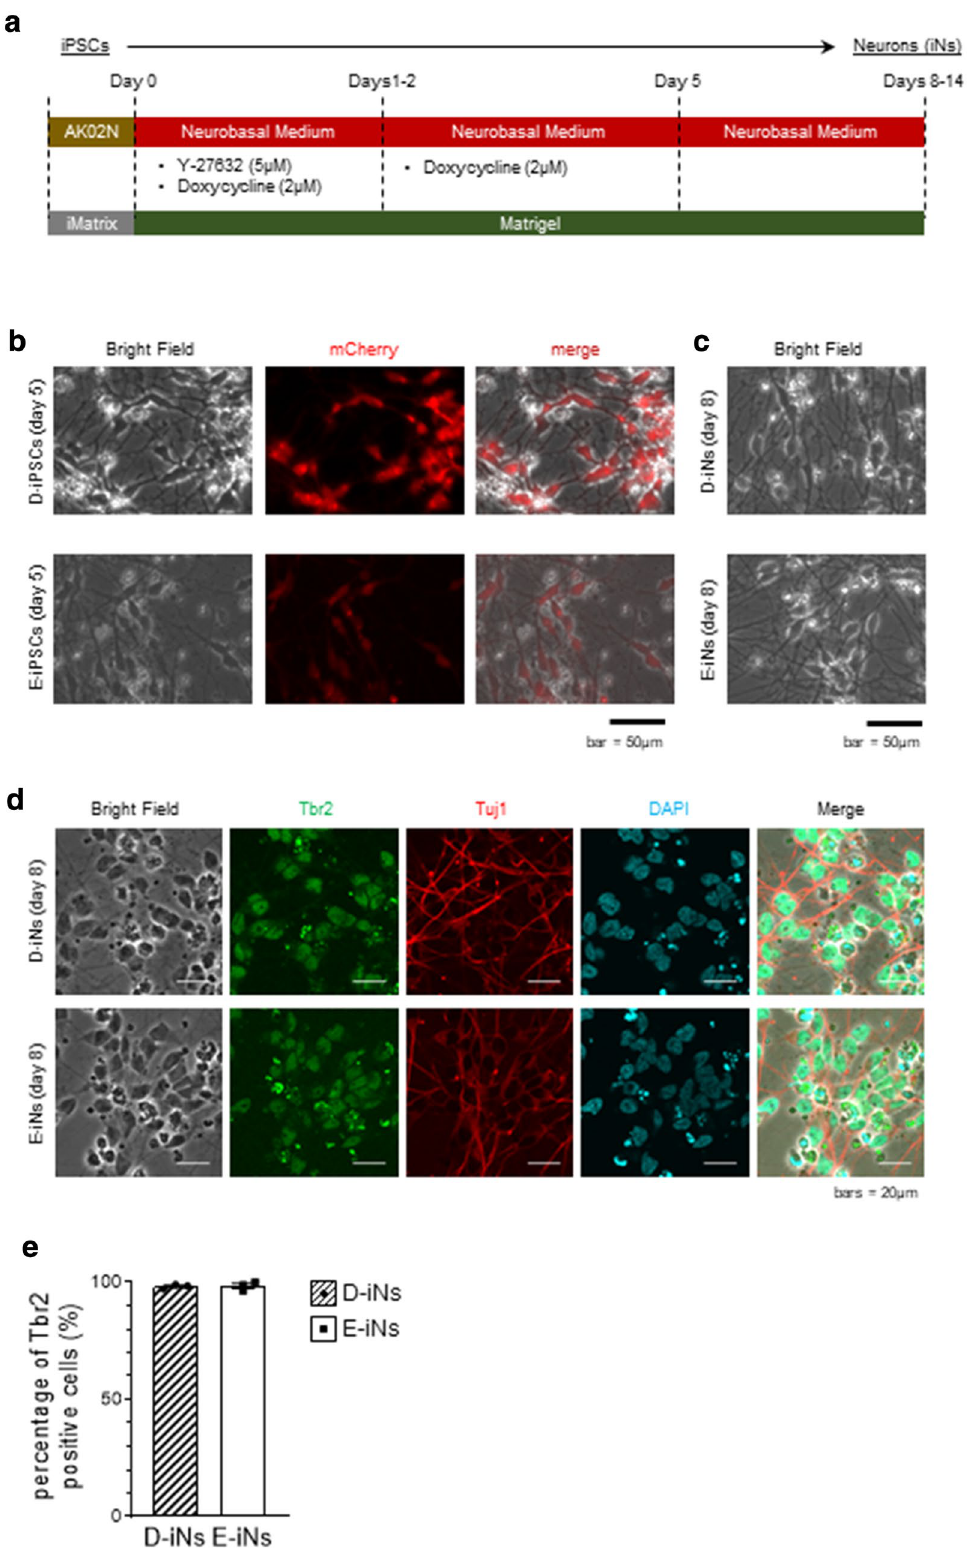
Figure 2. Neuronal differentiation with over-expression of NGN2 . (a) Schematic of the neuronal differentiation using the doxycycline-inducible NGN2 expression system. (b) mCherry expression at day 5. (c) Bright-field images of neuronal cells on day 8. (d) Immunostaining images of neuronal cells on day 8. (e) Quantification of the Tbr2-positive cells in (d) . Data are means ± SEM from three independent